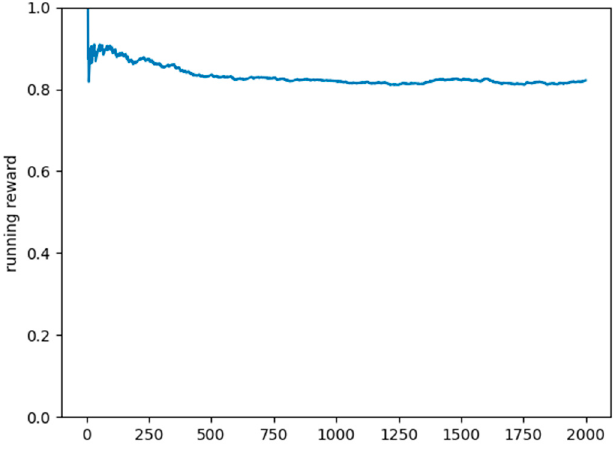
Figure 6. Plot of the mean running reward.